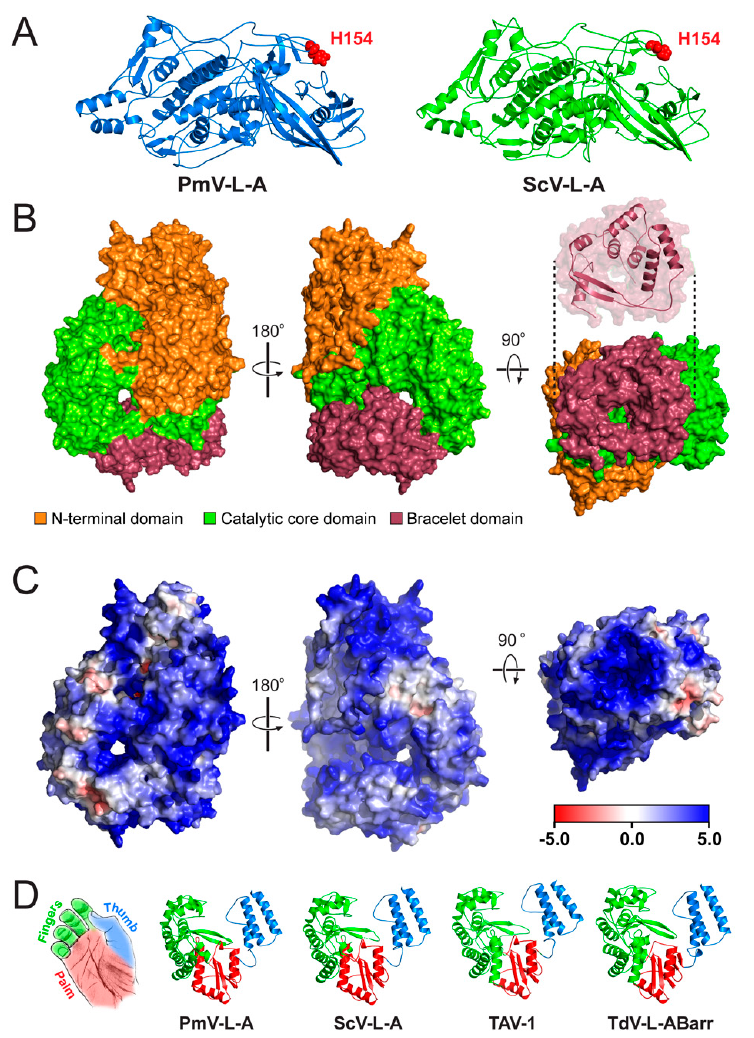
Figure 4. Structural models of the PmV-L-A Gag and Pol proteins and comparison to other totivirus polymerases. The AlphaFold2 server and energy minimization were used to generate molecular models of proteins encoded by PmV-L-A and related totiviruses. ( A ) Cartoon models of the Gag protein of PmV-L-A, compared to the crystal structure model of the Gag protein of ScV-L-A. The catalytic histidine (H154) is depicted in red in each model. ( B ) Surface model of the PmV-L-A Pol protein, representing the N-terminal domain (orange), catalytic domain (green), and bracelet domain (burgundy). The bracelet domain is also depicted as a cartoon to illustrate the channel structure more clearly. ( C ) Surface electrostatic model of the PmV-L-A Pol, using an adaptive Poisson Boltzmann solver (APBS). ( D ) Cartoon representation of the catalytic domain of four modeled totivirus polymerases, showing the finger, thumb, and palm subdomains.